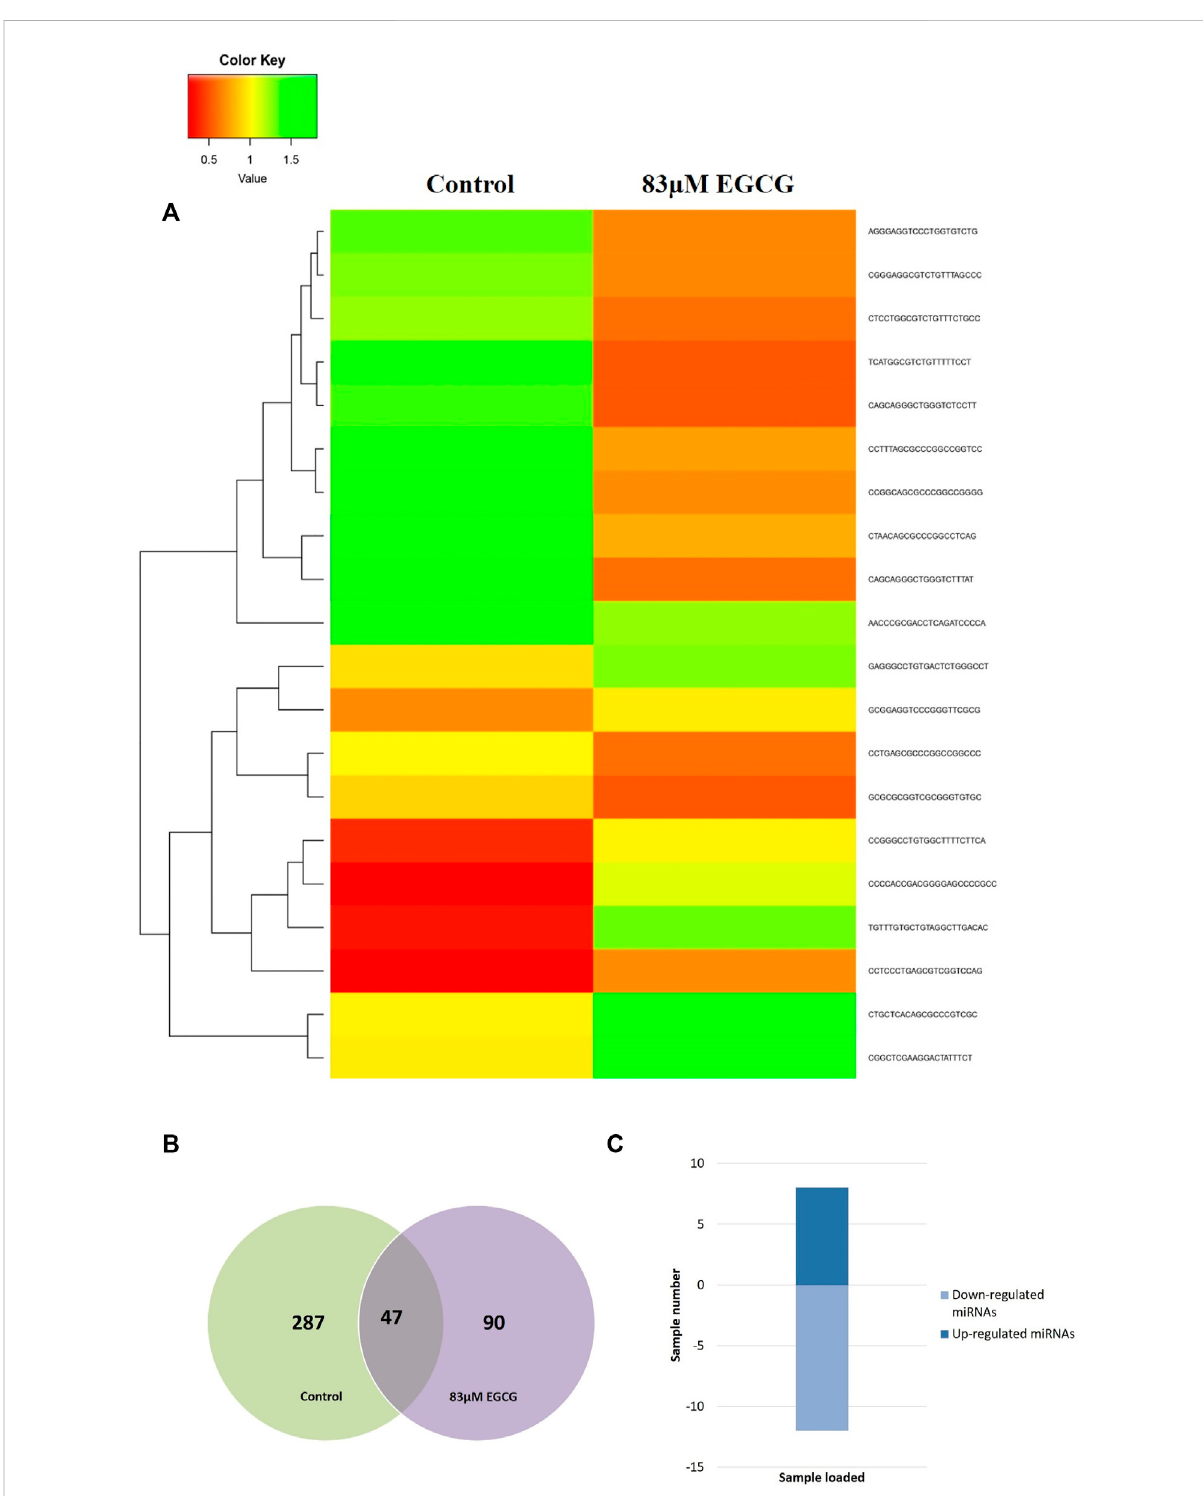
FIGURE 9 Dose-dependent expression pro fi le of putative novel microRNAs. (A) Relative microRNA expression levels of top 20 up- and down-regulated novelmicroRNAsinuntreatedcontrolvs.24 hof83 µMEGCGtreatment;Colorkey-red:up-regulation,green:down-regulation,andyellow:neutral expression. (B) Venn diagram depicting the dose-dependent responses of novel microRNAs to EGCG; (C) Summary set of up- and down-regulated known microRNAs exhibiting a change of expression after EGCG